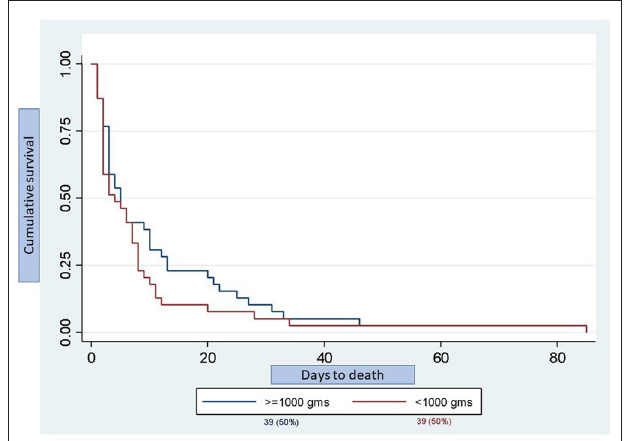
FIGURE 3 | Kaplan-Meier graph depicting day of death stratified by birth weight. Total number of deaths was 78 infants of which 39 infants (50%) were < 1,000g and 39 infants (50%) were ≥ 1,000g. There was no significant difference in the time to death between groups ( p = 0.242).